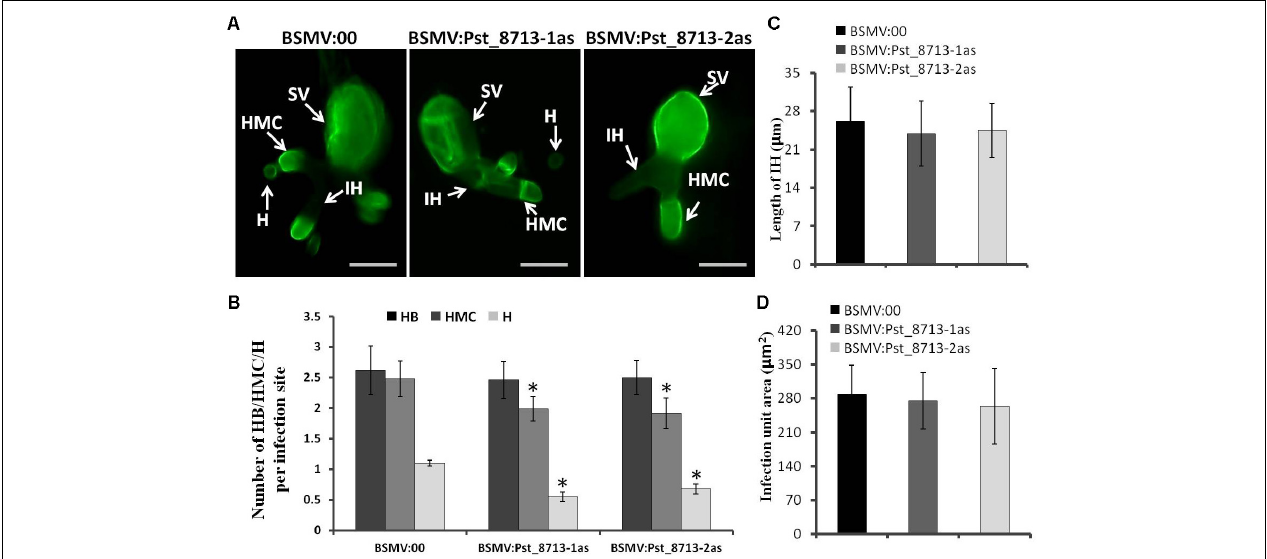
FIGURE 9 | Histological observation of fungal growth in wheat plants inoculated first with BSMV:00 or recombinant BSMV and then inoculated with isolate CYR32 (A) Fungal growth at 18 h after CYR32 inoculation. The fungal structure was stained with wheat germ agglutinin (WGA) and observed under a fluorescence microscope. Bars = 20 µ m. (B) The average number of HB, HMC and H in HIGS plants infected by CYR32. (C) Hyphal length, which is the mean distance from the junction of the sub-stomatal vesicle of the hypha to the tip of the hypha, measured using DP-BSW software. (D) Infection area, the mean area of the expanding hyphae plus the host cells, was calculated using DP-BSW software (unit in × 10 3 / µ m 2 ). All bars indicated means ± SE of three independent biological replicates with 50 unit areas per replicate, Asterisks indicate significant differences ( P < 0.05) using Student’s t -test. SV, sub-stomatal vesicle; HMC, haustorial mother cell; IH, infection hypha, H, haustorium, and HB, hypha branch.